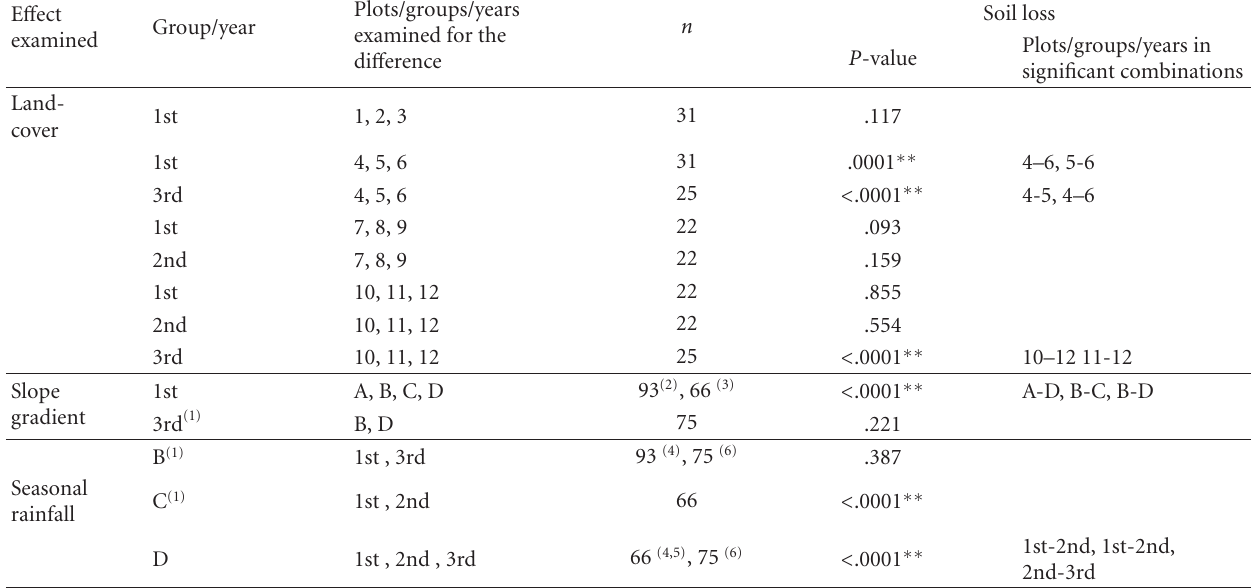
Table 5: Significant di ff erences in the mean daily soil loss between plots 1 to 12, between groups A to D and between 1st to 3rd years analyzed by either the Kruskal-Wallis test or the t